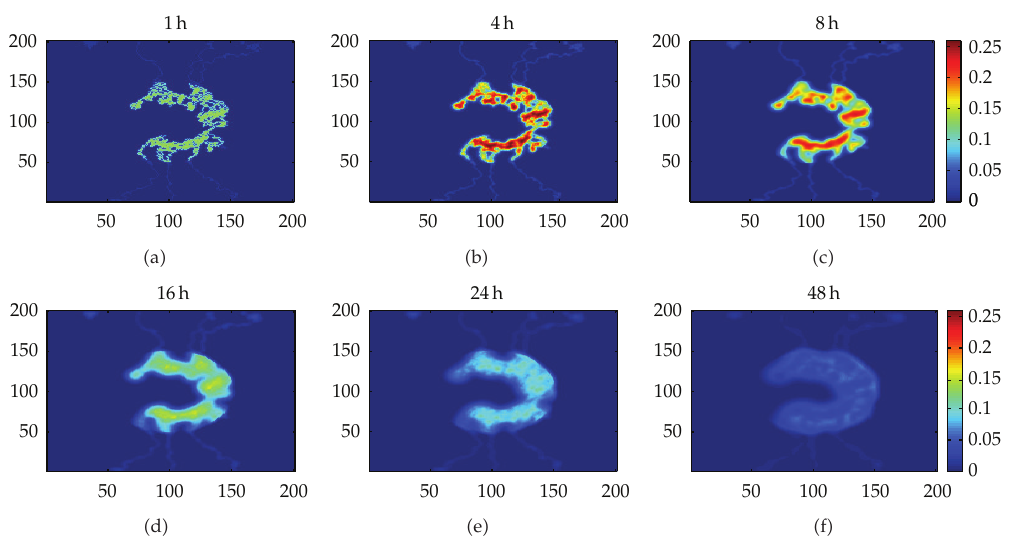
Figure 5: The simulation result of drug concentration after